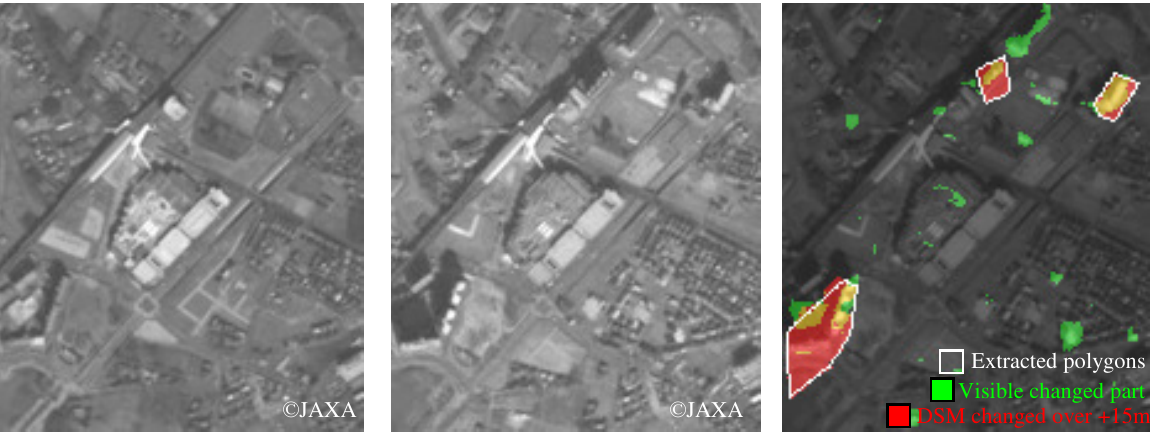
Figure 9: Part of change detected image Leftt: 1 st orthoimage, Center: 2 nd orthoimage, Right: change detected image overlayed with 2 nd orthoimage and extracted polygons